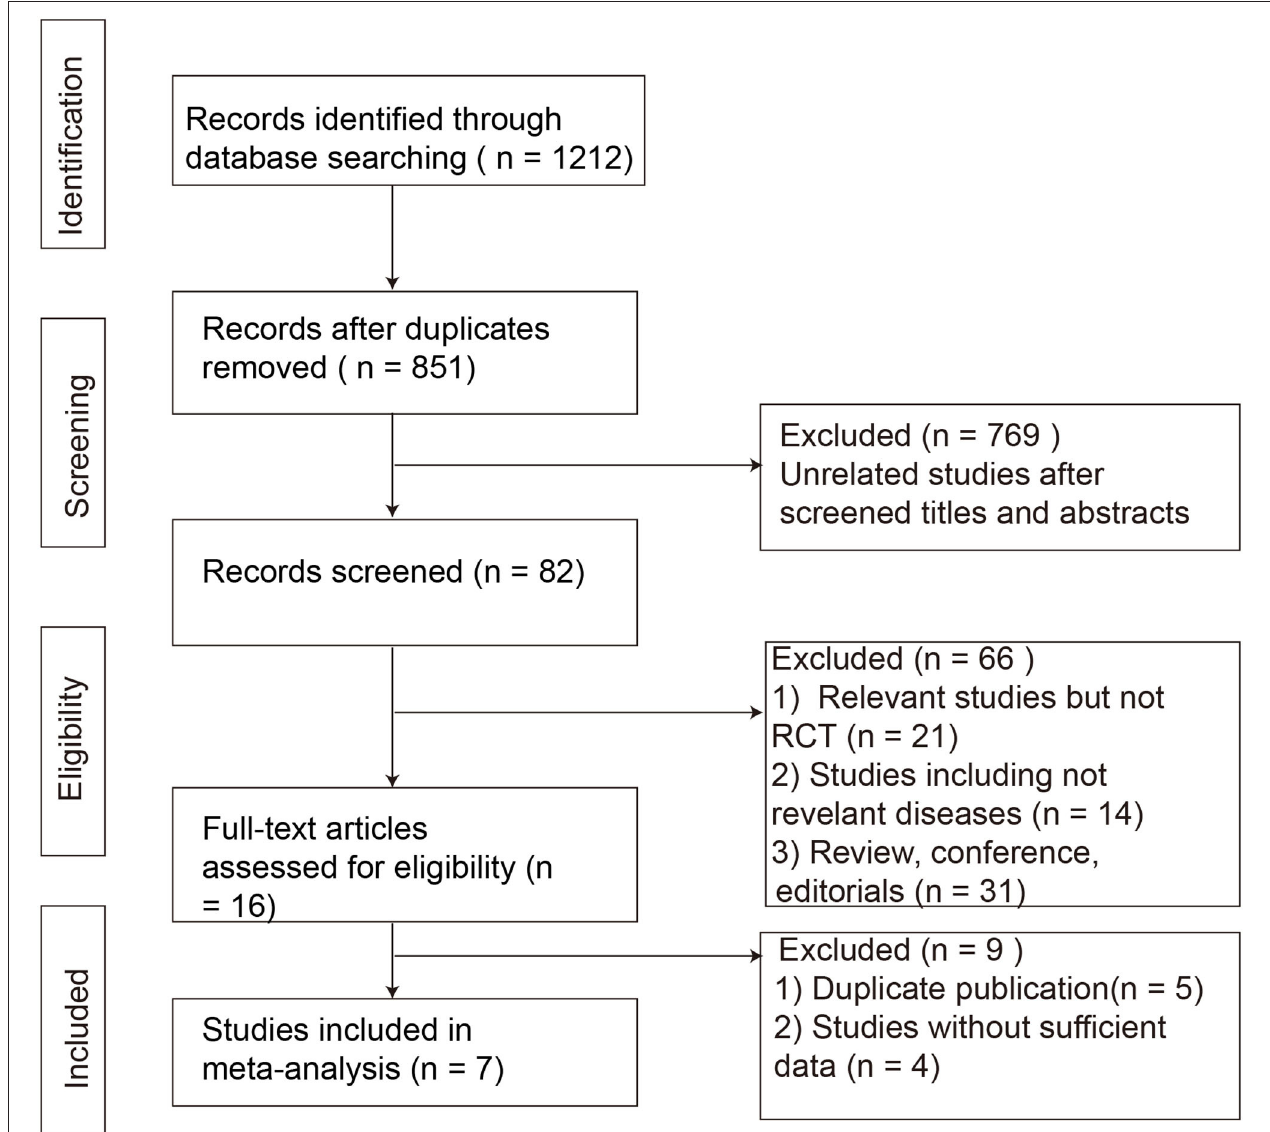
FIGURE 1 | Flowchart of study selection strategy in the systematic review and meta-analysis. RCTs, randomized controlled trials.